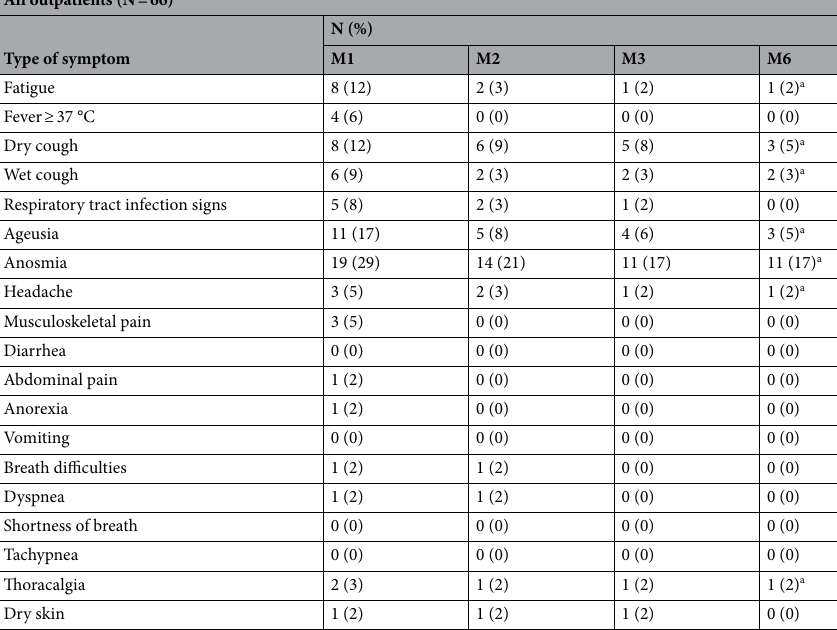
Table 8. Incidence of COVID-19 symptoms among 66 outpatients during follow-up phase. Although our analysis primarily focused on acute symptomatology during the study’s initial phase, incidence of symptoms during an extended monitoring study phase with a median follow-up of 219 days (mean-222; min-32, max- 486) is presented in Table 8. We evaluated in total 23 (58%) of the patients from our Cohort with 2 Negative Tests, and 43 (66%) of the patients from our Cohort with New Algorithm, respectively. During the first month following COVID-19 diagnosis, certain symptoms persisting with a frequency greater than 10% in outpatients were: anosmia (29%), ageusia (17%), fatigue (12%) and dry cough (12%), respectively. However, at the 6 month follow-up, only anosmia was detected with a higher frequency (17%). Assuming that patients no longer had a reason to deny symptoms after quarantine release, we conducted evaluations jointly for both cohorts. Only patients who agreed to enter the extended follow-up phase were included in our analysis. COVID‑19 coronavirus disease-19, M1, M2, M3, M6 number of months after COVID-19 diagnosis during follow-up phase. a Certain patients continuing to evince symptoms at the time of